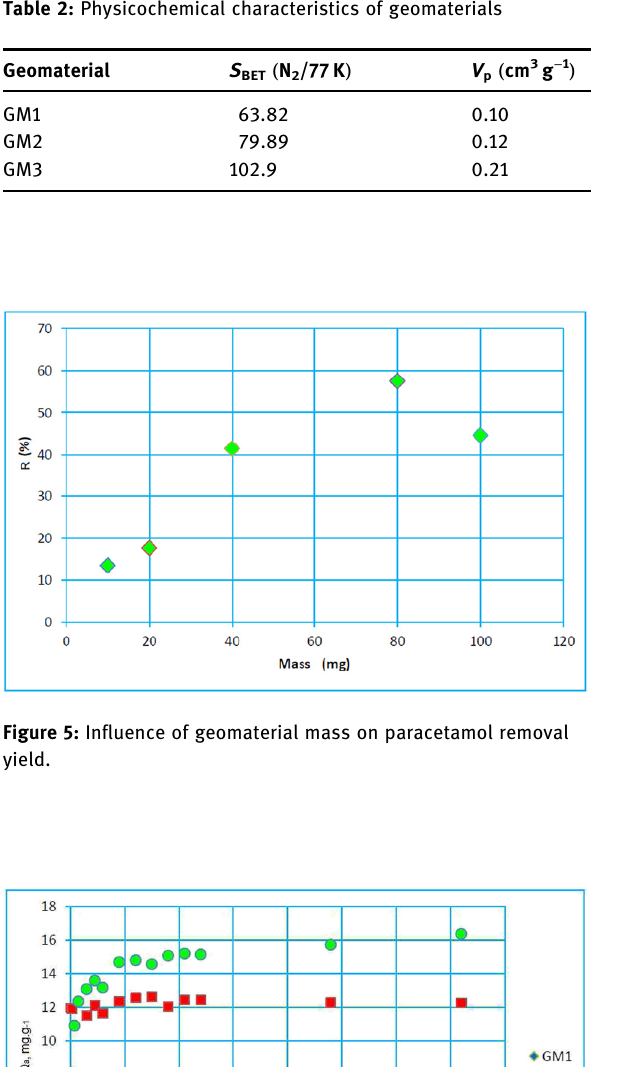
Table 2: Physicochemical characteristics of geomaterials